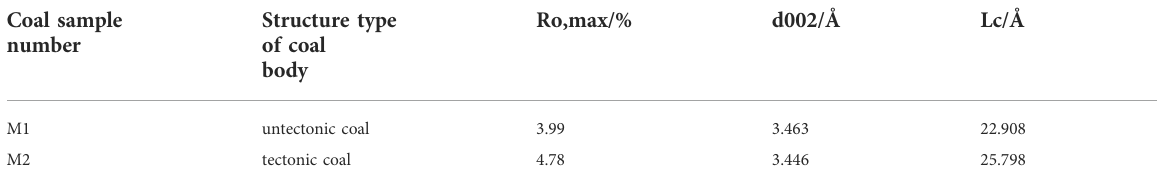
TABLE 2 R o,max and XRD analysis data of different types of anthractie coal (modi fi ed from Jing et al., 2010).